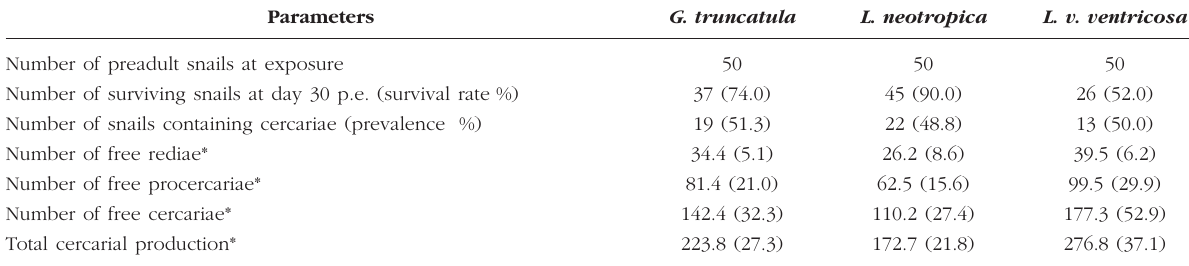
Table II. – Counts of P. daubneyi rediae and cercariae in three species of lymnaeids at day 65 p.e. at 20 °C (experiment B).